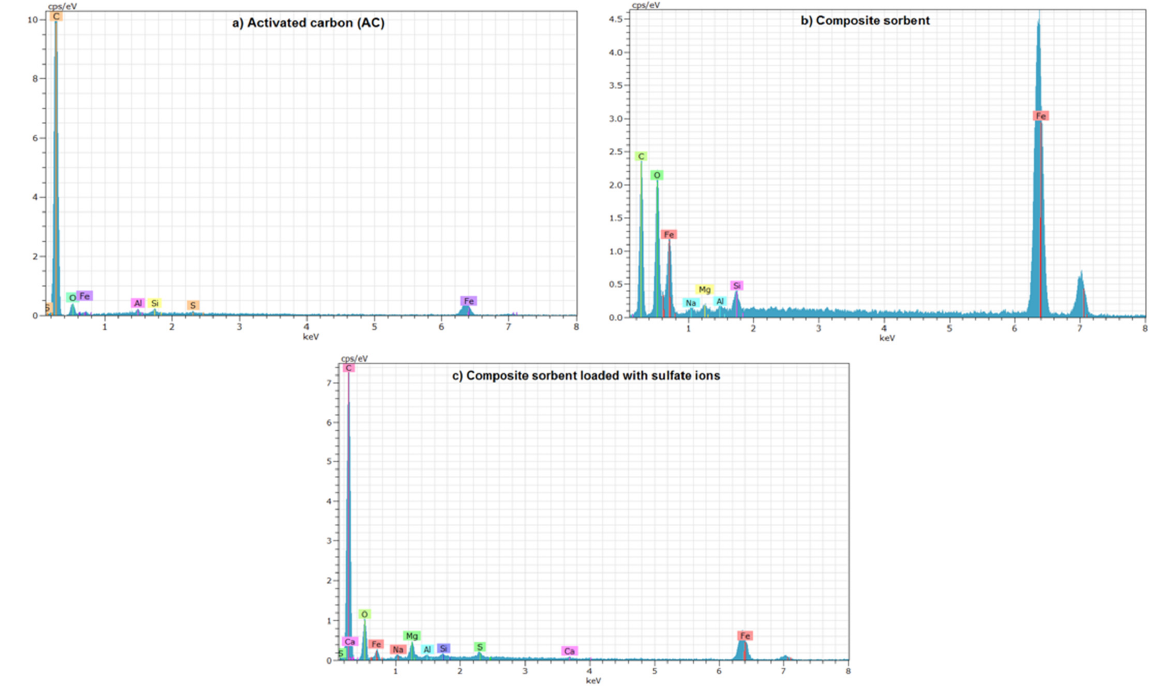
Figure 5. EDS spectrum of ( a ) AC, ( b ) composite sorbent before sorption and ( c ) composite sorbent after sorption of SO 42 − ions.